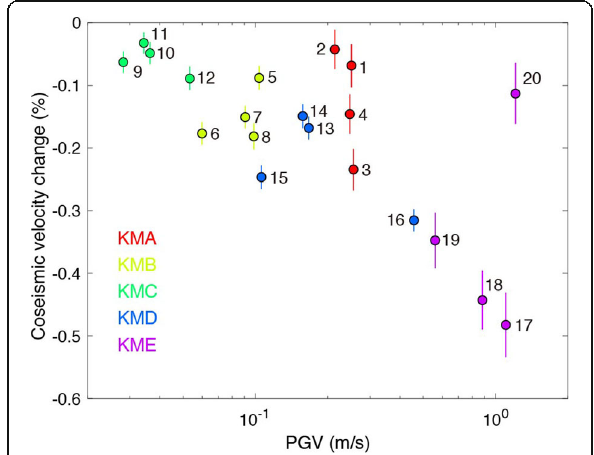
Fig. 7 Comparison between coseismic velocity changes and PGV at each station, denoted by its number. The colors of the station symbols indicate their